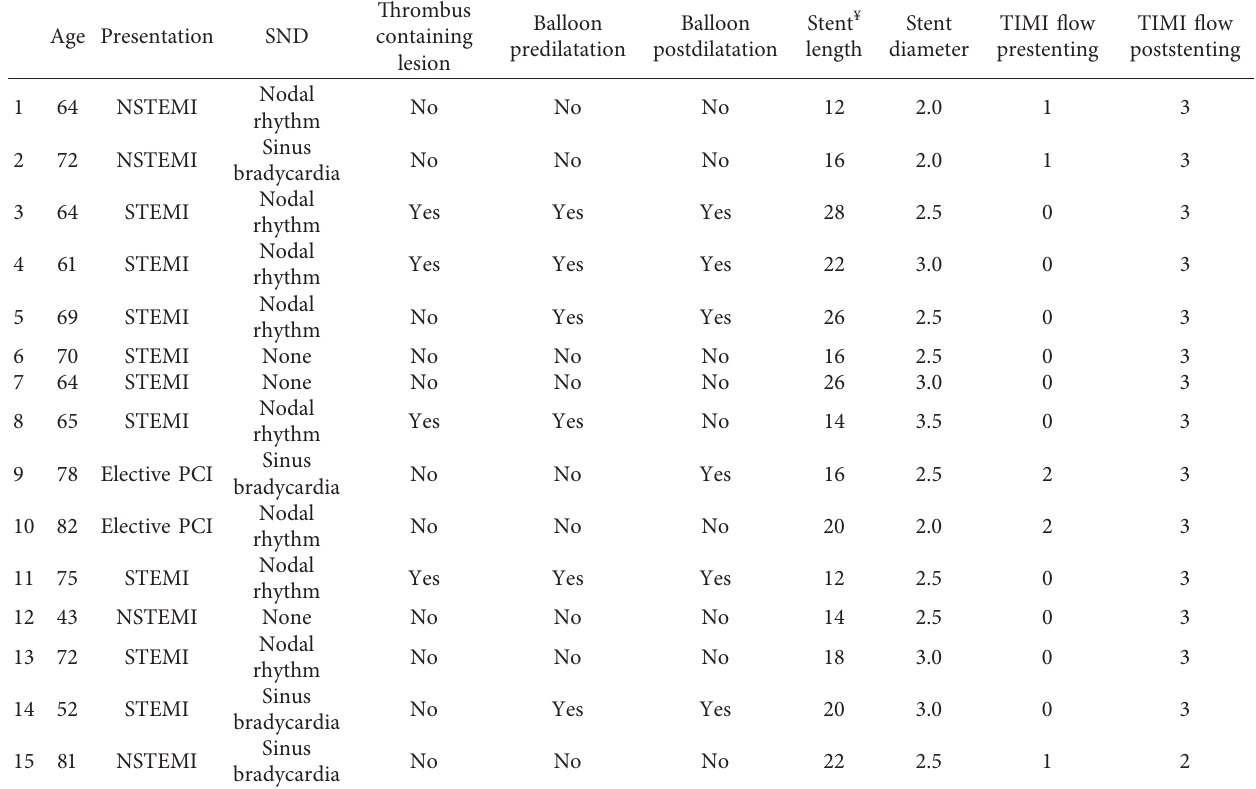
Table 4: Angiographic data of the study population.